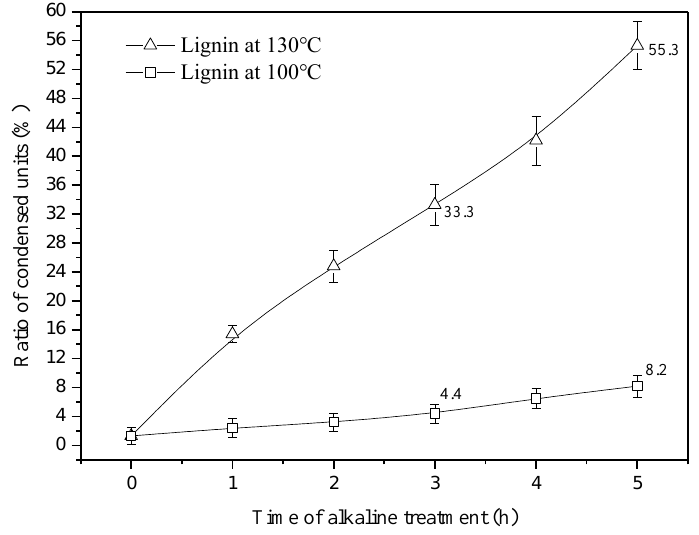
Figure 5. Ratio of condensed lignin in jute fibers pretreated at 100 and 130 °C.